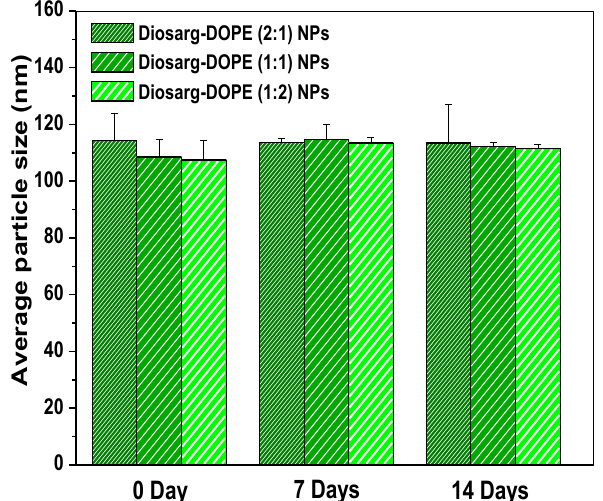
Figure 2. Storage stability of the Diosarg-DOPE (2:1, 1:1, 1:2) NPs in distilled water after 0 day, 7 days and 14 days; the average particle size was measured by the dynamic light scattering instrument.